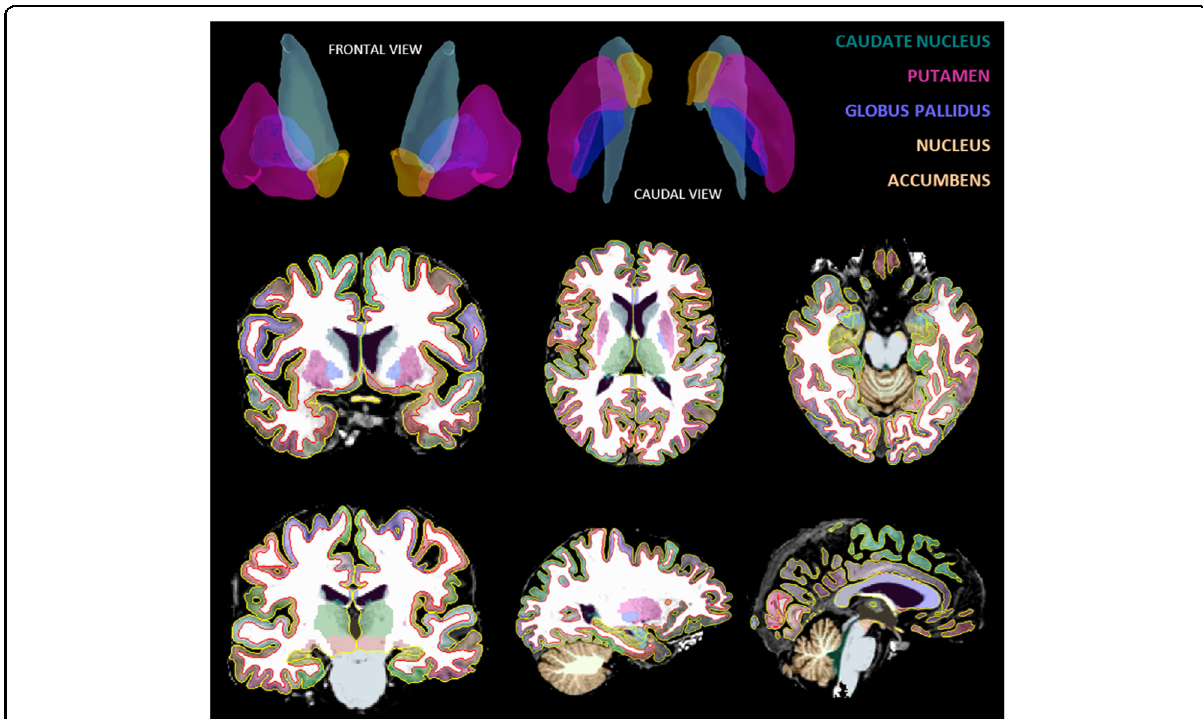
Fig. 2 Volumetric 3D segmentation of high-resolution 3D T1-weighted MR images using Freesurfer 6.0.0 (Fisher et al. 2012). Caudate nucleus, putamen, globus pallidus, and nucleus accumbens volumes were extracted from whole-brain segmentation images. Participants were scanned at three time points: prior to ECT (baseline, t 0 ), one week after ( t 1 ), and six months after ECT completion ( t 2 ). The volumetric data were normalized to account for differences in total brain volume using a standard approach (Jack et al. 48